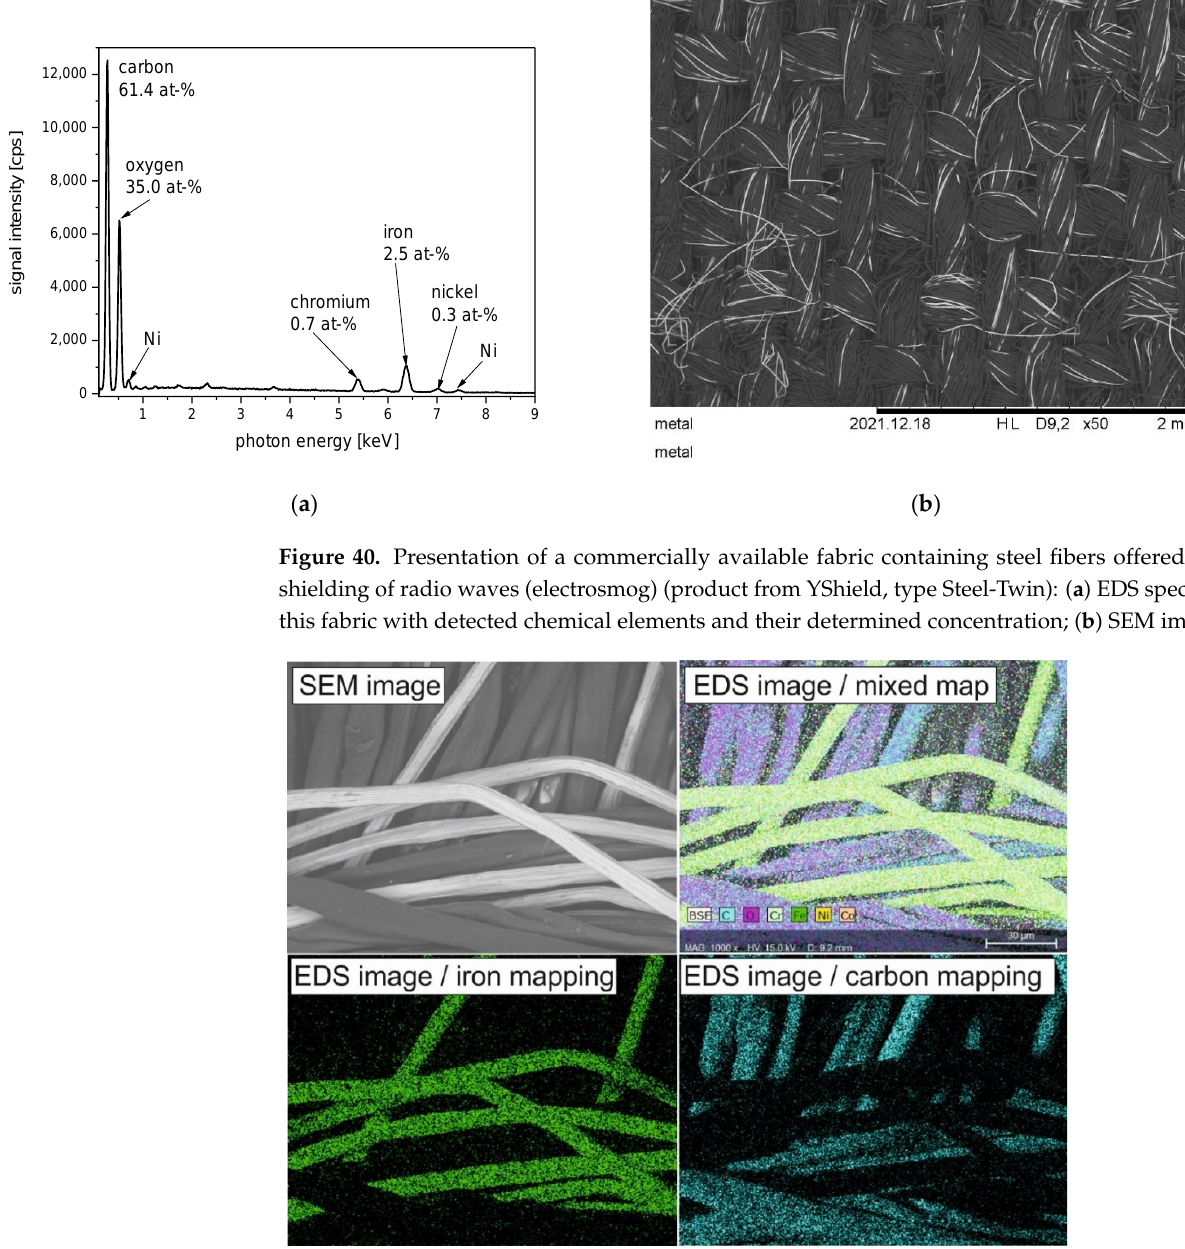
Figure 41. SEM image and related EDS images from fabric containing steel fibers (Steel Twin, YShield EMR-Protection). The mappings for the chemical elements iron and carbon are especially compared. The last example in this review is a catalytic active textile material able to convert CO to CO 2 at room temperature. A polypropylene melt blown is covered with TiO 2 nanoparticles, and the composite material is subsequently coated with gold via a PVD process. The triple interface between the gas phase, TiO 2 , and gold is the catalytic active site. In the